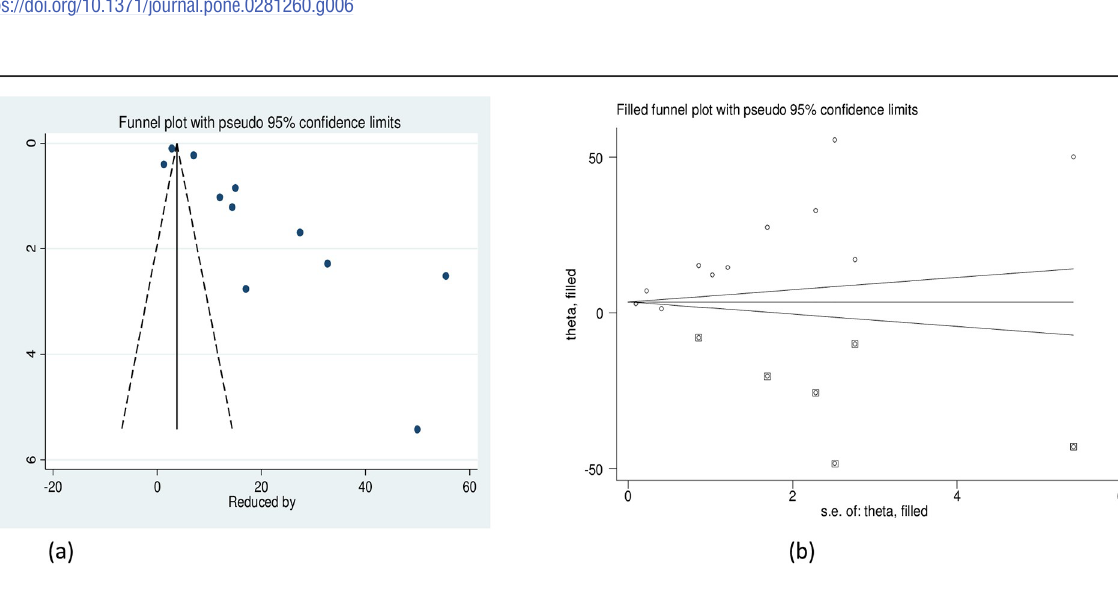
PLOS ONE | https://doi.org/10.1371/journal.pone.0281260 February 7, 2023 12 /